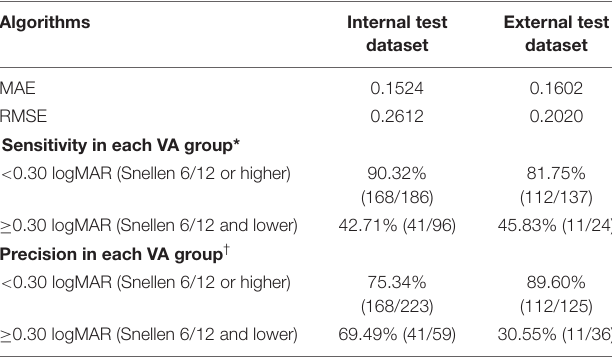
TABLE 3 | The performances of the prediction model in the internal ( n = 282) and external test datasets ( n = 161).